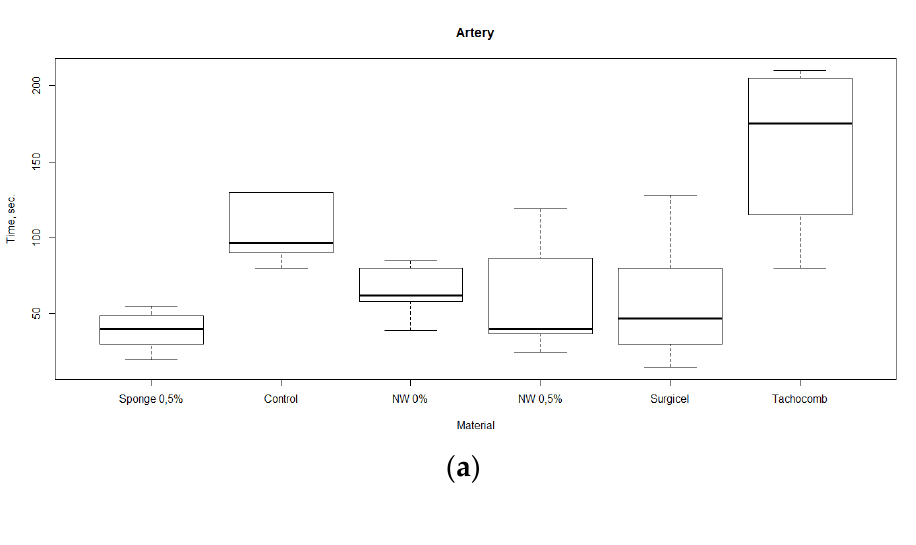
Figure 3. Rates of bleeding arrest (time until cessation of bleeding) in the experiments with chitosan sponges containing different amounts of ChNF.